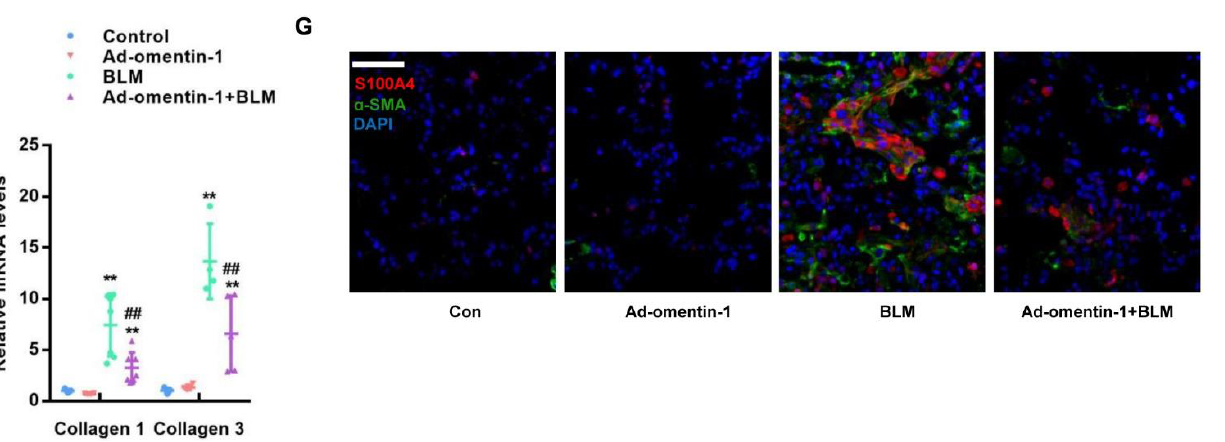
Figure 3. The effect of omentin-1 on BLM-injured mice by preventative treatment. ( A ) Experimental design: The preventive treatment with ad-omentin-1 was performed on D3 before BLM and D4 after BLM. BLM (1.25 mg/kg) was injected to induce fibrosis in wild-type mice; ( B )The content of omentin-1 in lung tissue detected by western blotting with cropping gel at the relative molecular size ( n = 3); ( C ) Representative micrographs of H&E staining of lung tissue (Bar = 50 µ m, n = 5). ( D ) Representative micrographs of Masson trichrome staining, immunohistochemical staining of lung sections for collagen I (Col1) and Col3 (Bar = 50 µ m, n = 5). ( E ) Ashcroft score to grade fibrosis scale ( n = 5). ( F ) The expression of Col1 and Col3 mRNA in the lung tissue of mice detected by qPCR ( n = 4). ( G ) The expression and localization of α -SMA and S100A4 in lung tissue detected by immunofluorescence (bar = 50 µ m, n = 5). The data are presented as the mean ± SD. ** p < 0.01 vs. control group. ## p < 0.01 vs. BLM